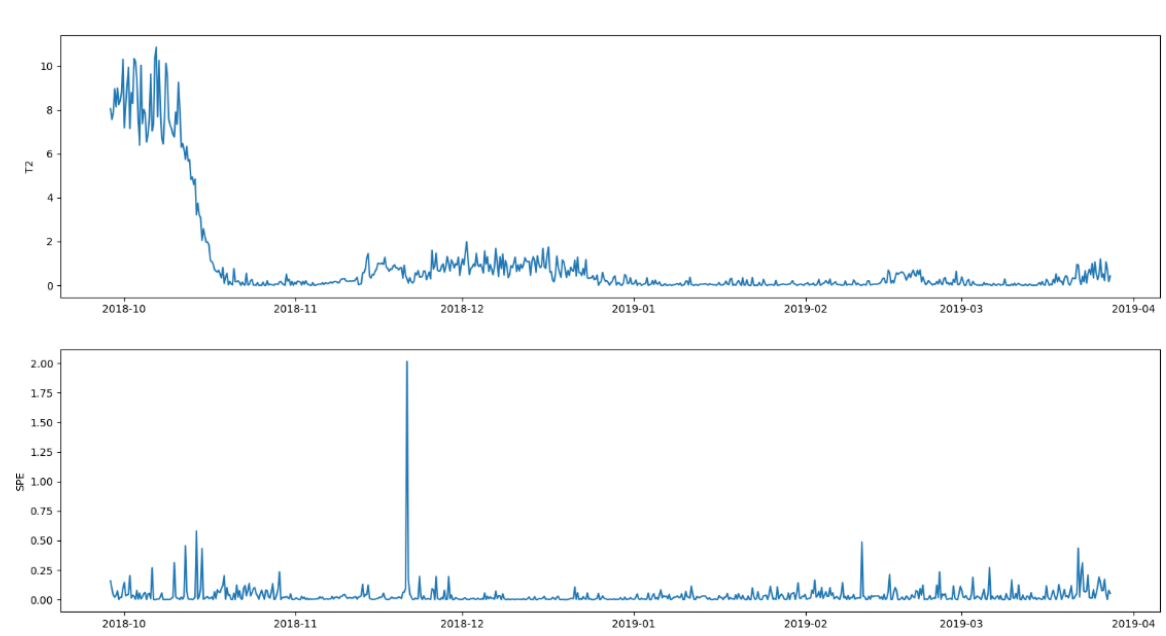
Figure 3: Anomalies captured by SPE metric